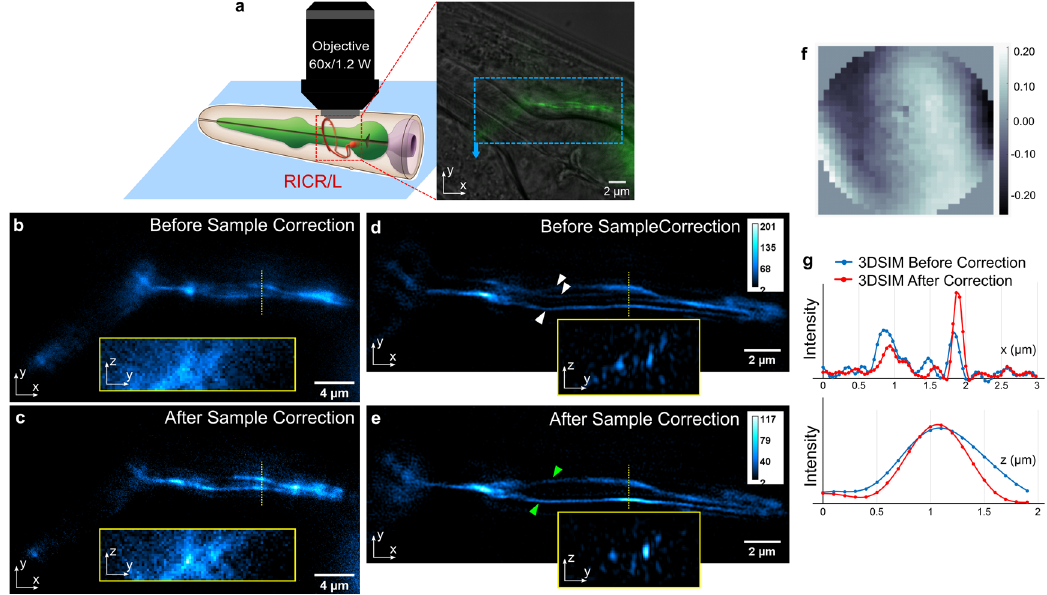
Fig. 6 Live C. elegans with TBH-1::GFP expressed in RIC interneurons in the lateral ganglion. a Graphic rendition of the RICR/L neurons in adult C. elegans (graphic from nervous system poster in WormAtlas 60 : http://www.wormatlas.org) and the overlay of wide fi eld fl uorescence image and DIC phase image. b Wide fi eld image of axon before AO correction. c Wide fi eld image of axon after AO correction. d 3D-SIM image of axon before AO correction and the y-z slice cut through the dashed yellow line. e 3D-SIM image of axon after AO correction and the y-z slice cut through the dashed yellow line. f The corrective wavefront applied on the DM, units in microns. g The line pro fi les across the axon in 3D-SIM images.